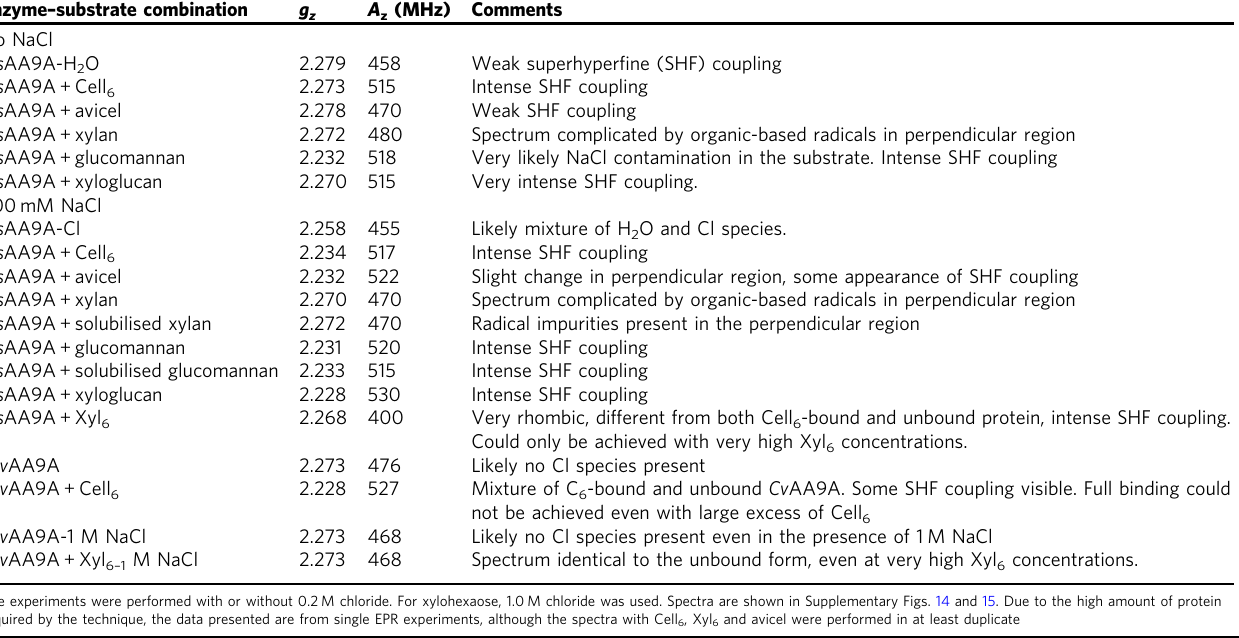
Table 3 Spin-Hamiltonian parameters (parallel region) for Ls AA9A and Cv AA9A in contact with substrates Enzyme – substrate combination g